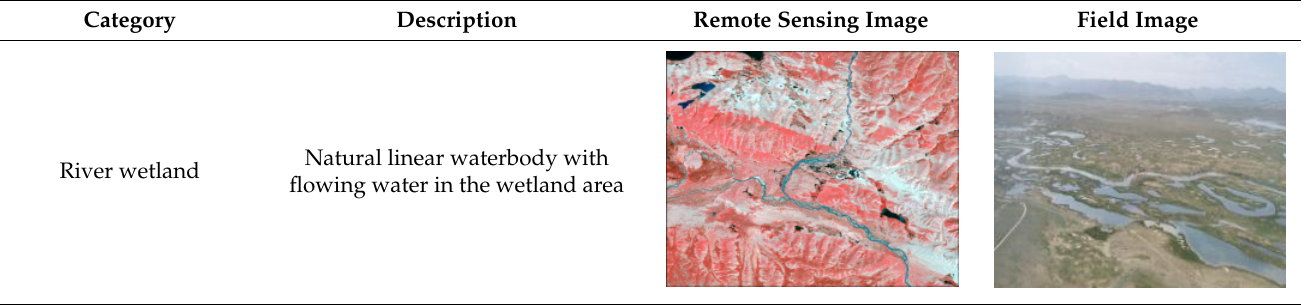
Table 1. Wetland classification system for remote sensing in the YRSNP.